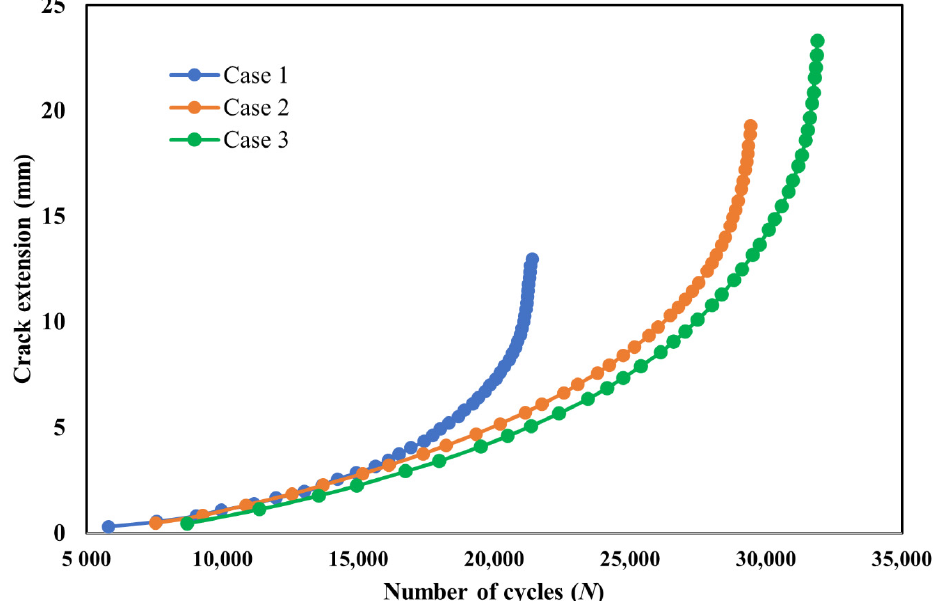
Figure 16. Calculated fatigue life cycles for the three cases.